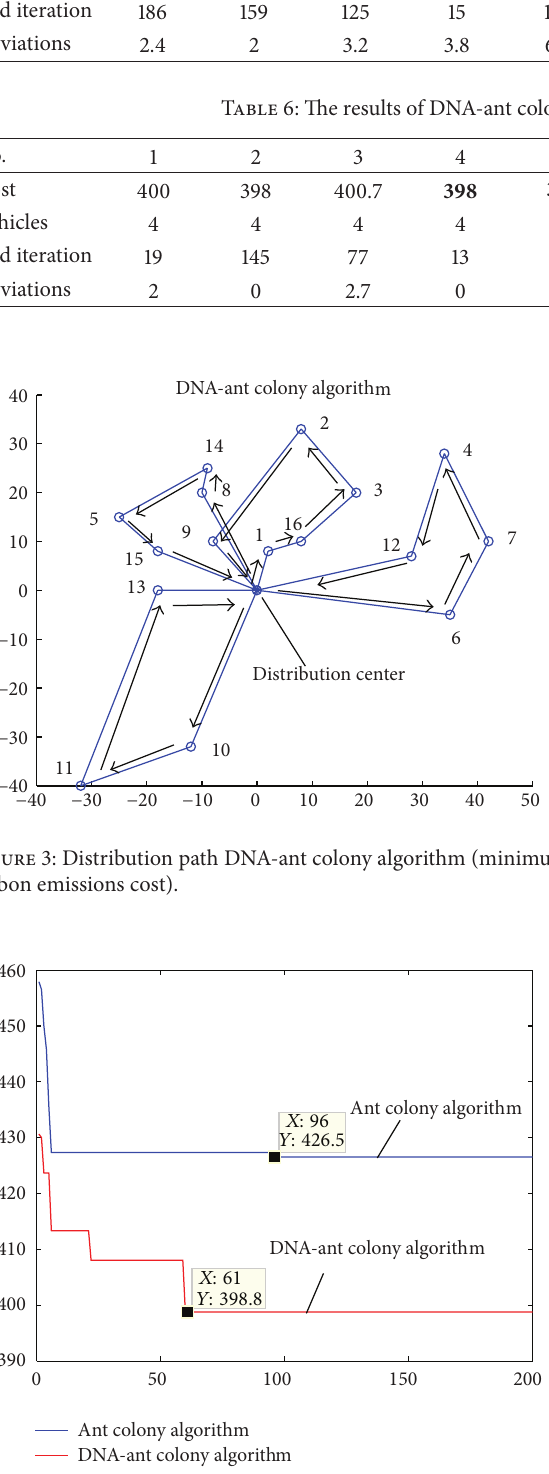
Figure 4: Minimum carbon emissions cost optimization